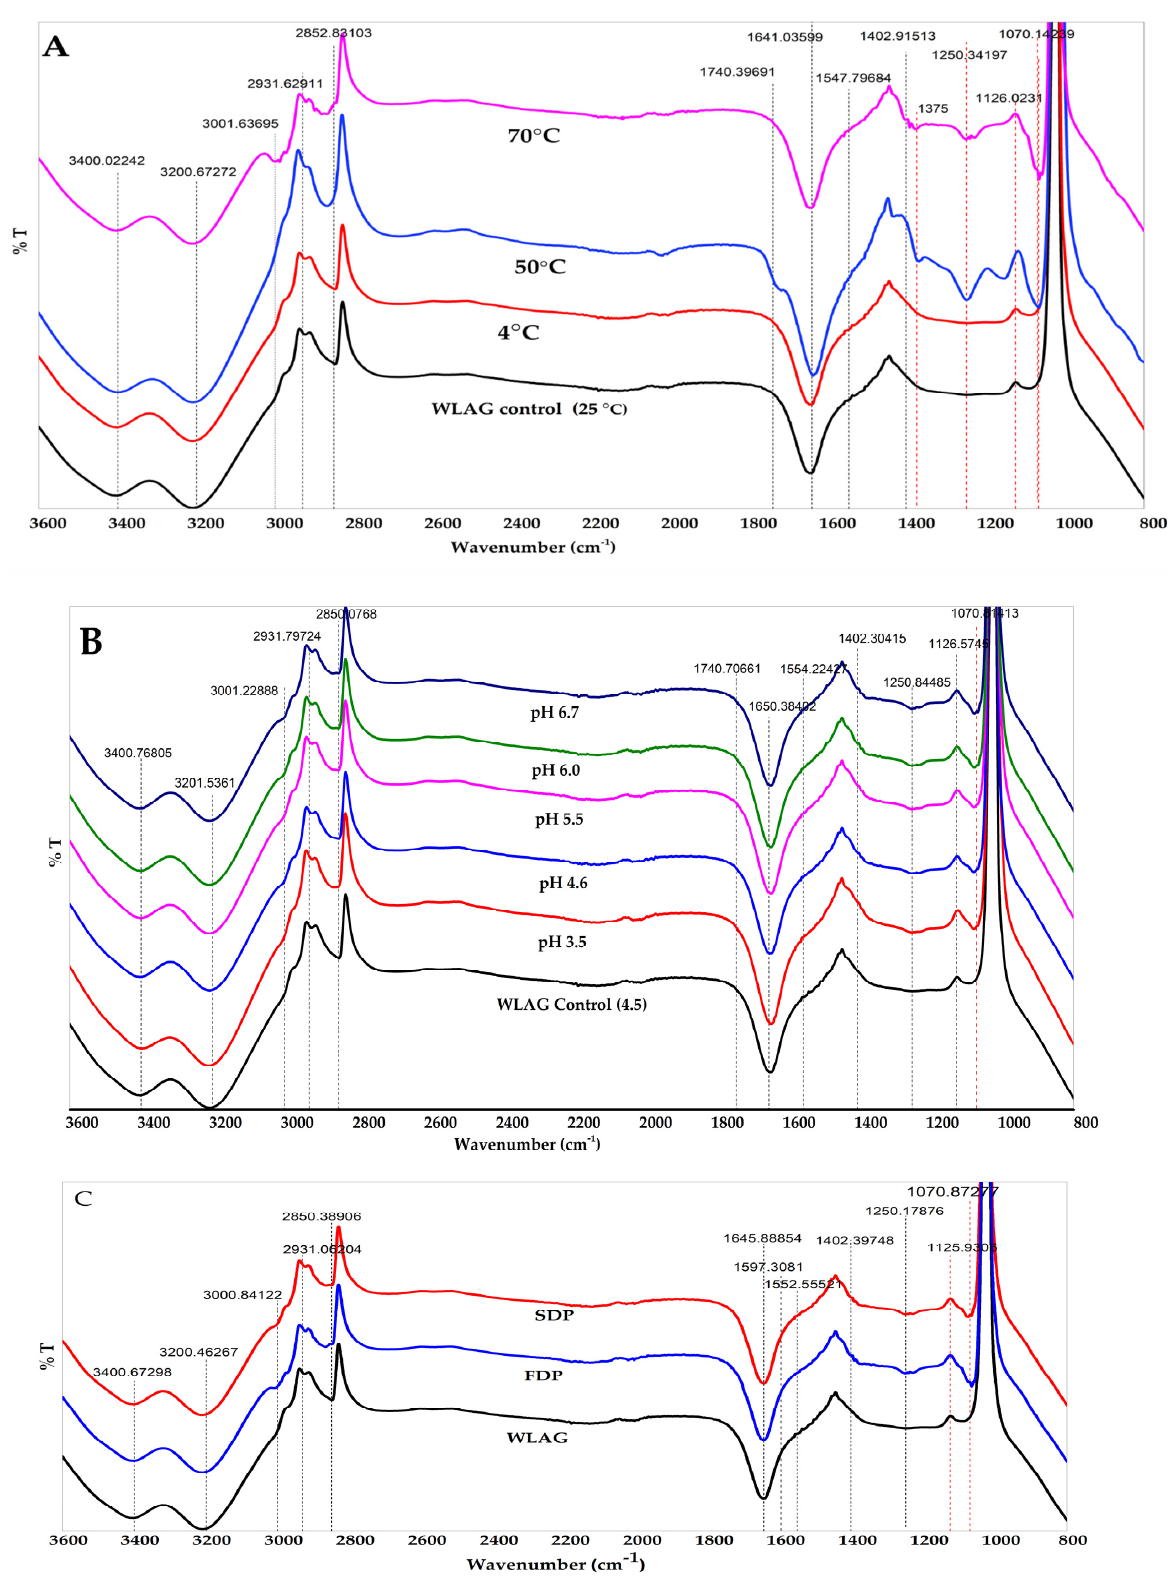
Figure 2. FTIR spectra of ( A ) anthraquinone extracted from whole leaf Aloe vera gel (WLAG) at various temperatures, ( B ) anthraquinone extracted from whole leaf Aloe vera gel at various pH conditions and ( C ) anthraquinone extracted from the whole leaf Aloe vera gel (WLAG), freeze-dried powder (FDP) and spray-dried powder (SDP) of Aloe vera